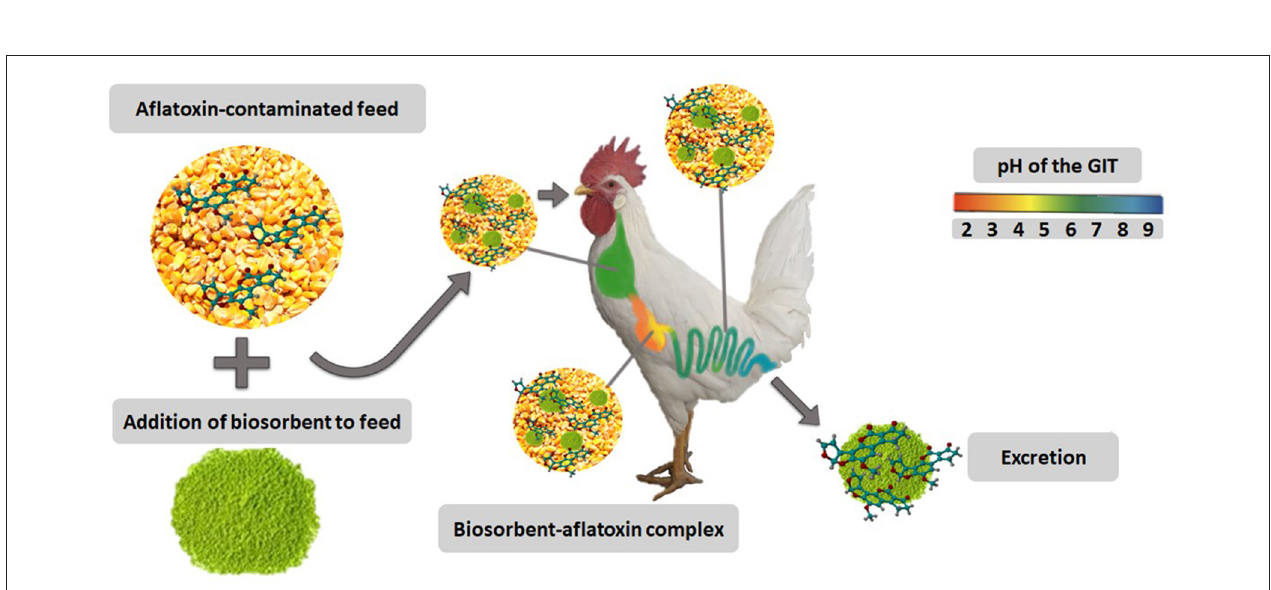
FIGURE 3 | Biosorbents and their mode of action. Created with BioRender.com.